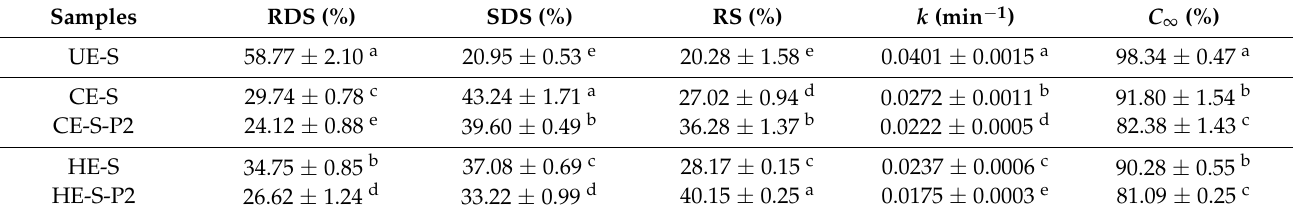
Table 1. Simulated in vitro gastrointestinal digestion properties of cold and hot extruded noodles with or without